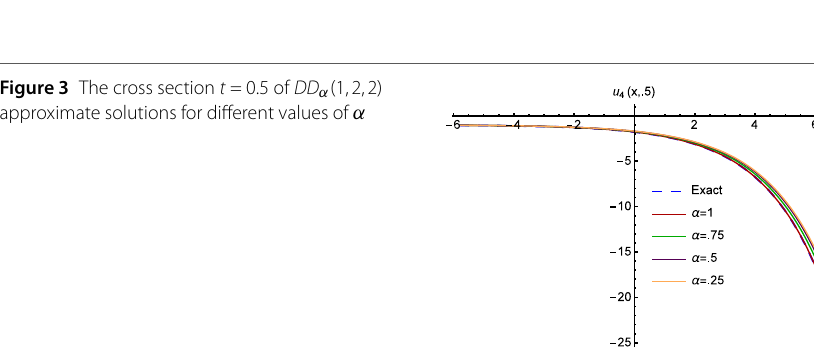
Figure 3 The cross section t = 0.5 of DD α (1,2,2) approximate solutions for different values of